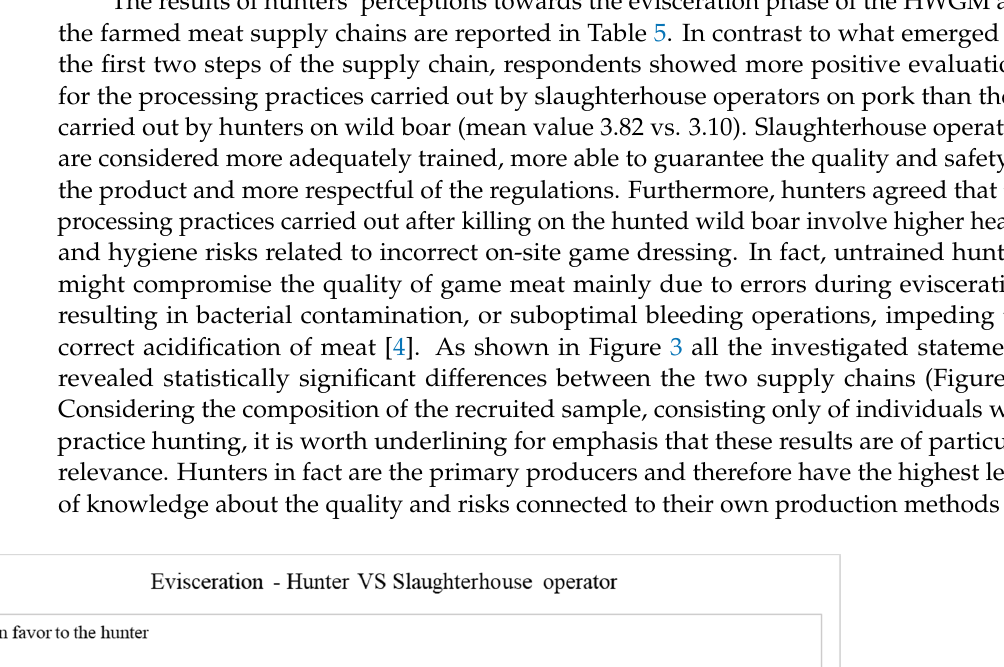
Table 5. Evisceration — Hunter vs. Slaughterhouse operator.